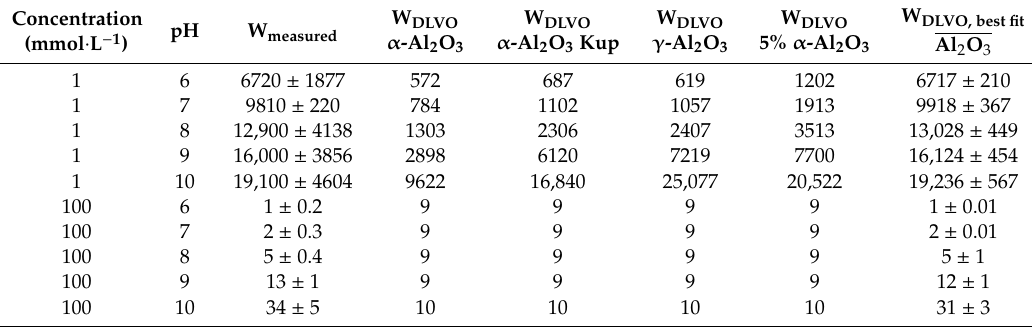
Table 2. Measured stability ratio W measured for NaCl electrolyte solution. Theoretical W DLVO values calculated with Equation (6) for di ff erent edge electrokinetic potentials estimated with α -alumina